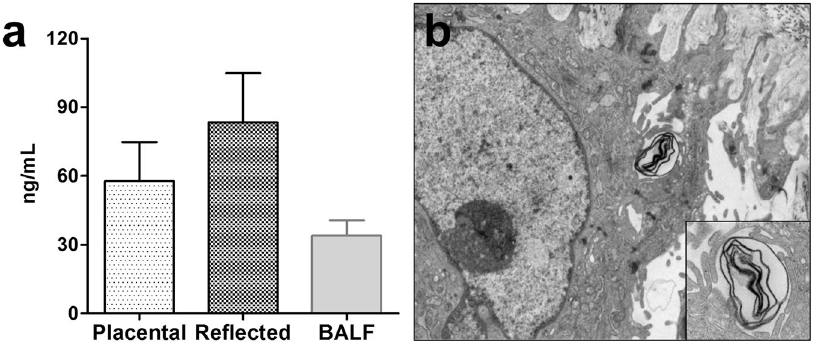
Figure 4. hAM explants actively secrete PS components. ( a ) SP-D is secreted into cell culture medium by hAM. Conditioned medium of reflected hAM explants shows higher SP-D concentrations (83.4 ± 21.5 ng/mL, n = 5) compared to placental hAM (57.8 ± 16.9 ng/mL, n = 5). As positive control, porcine BALF (34.0 ± 6.7 ng/mL, n = 2) was used. Illustrated are mean + S.D. ( b ) Ultrastructural analysis of hAM reveals lamellar body-like structures inside the cytoplasm, crucial for PS transportation and secretion. Magnification: 8900x and 18000x.